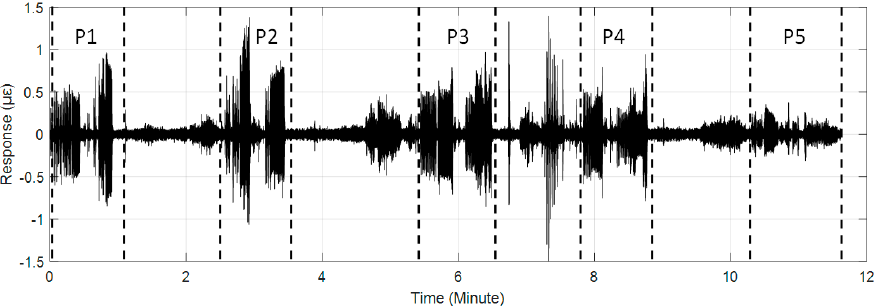
Figure 6. Distributed structural vibration of #159 zone of the tunnel wall under multiple position perturbations.